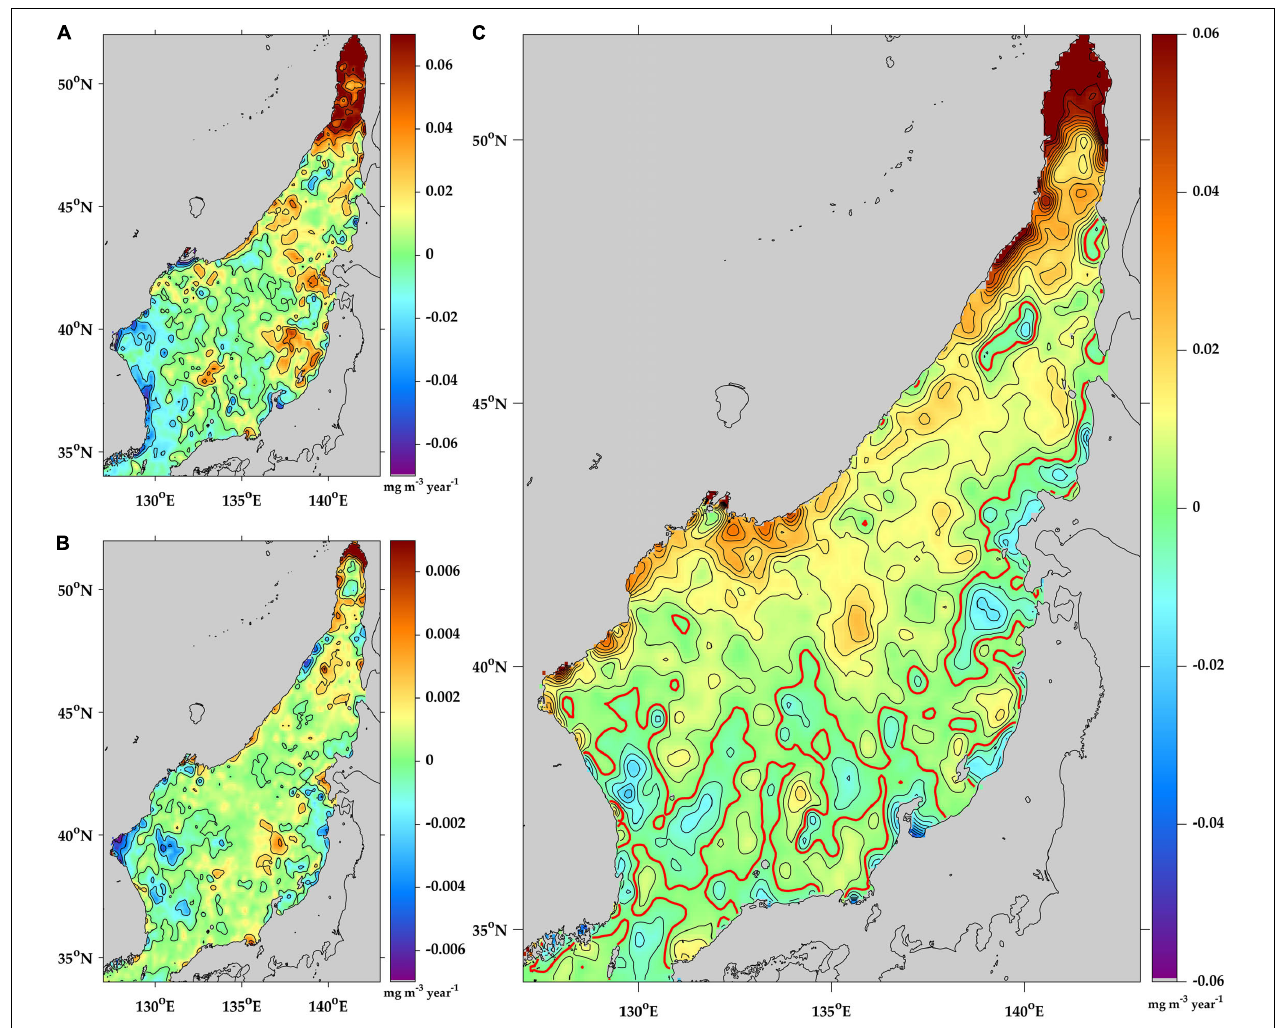
FIGURE 7 | Spatial distribution of (A) MODIS chlorophyll- a concentration trends (mg m − 3 yr − 1 ) for the period 2003–2015 (Park et al., 2020a) and (B) differences in the trends, comprising oridinary trend minus multi-variational fitted trend in the East Sea (Sea of Japan) for the same period (2003–2015), and (C) trends in chlorophyll- a concentrations for the period